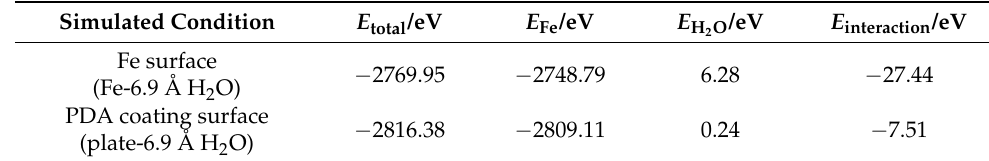
Table 2. Interaction energy of the surface with the water molecular layer within 6.9 Å.